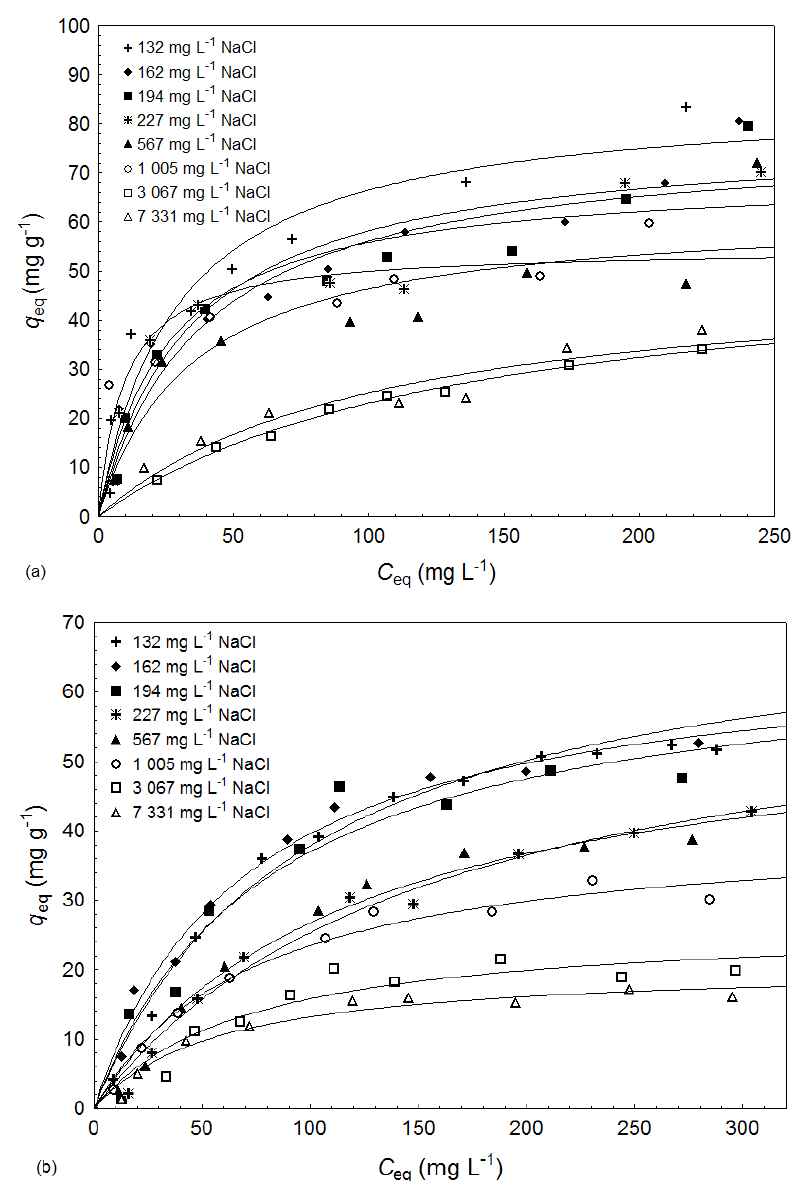
Figure 2. Langmuir isotherms for biosorption of Cr(III) ions by (a) Enteromorpha prolifera and (b) Spirulina sp. for different initial NaCl concentrations: 132 – 7331 mg L -1 ( C 1.0 g L -1 , pH 5, S